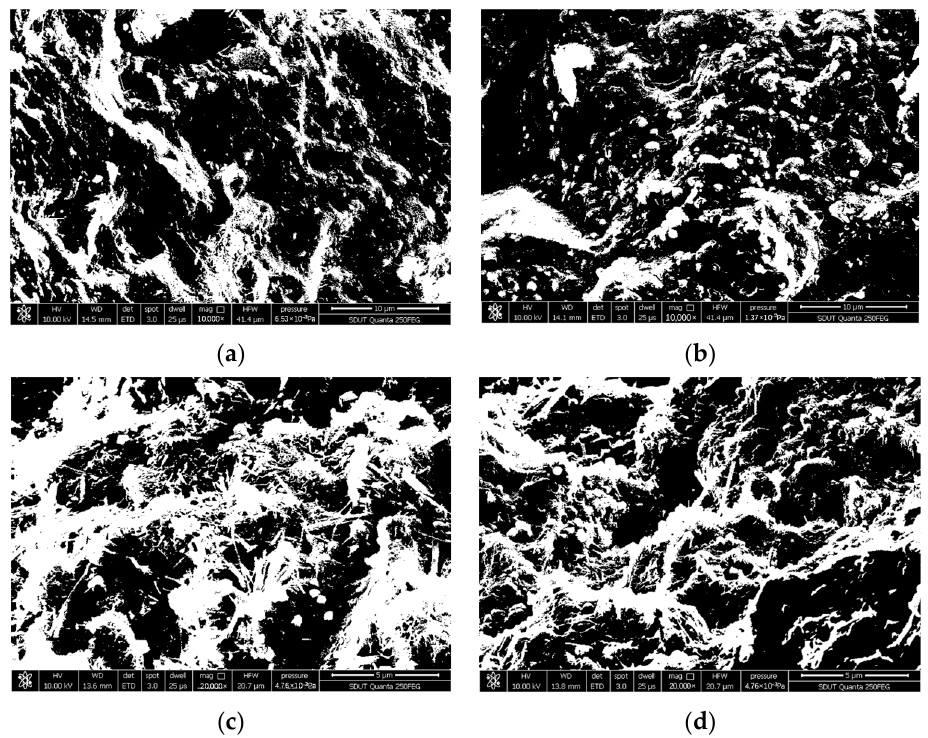
Figure 10. SEM image after binarization treatment: ( a ) NAC (10,000); ( b ) CSAC (10,000); ( c ) NAC (20,000); ( d ) CSAC (20,000). Figure 11 shows the fractal dimension accuracy of SEM images. R 2 is high and can better reflect the nonlinear degree of images.